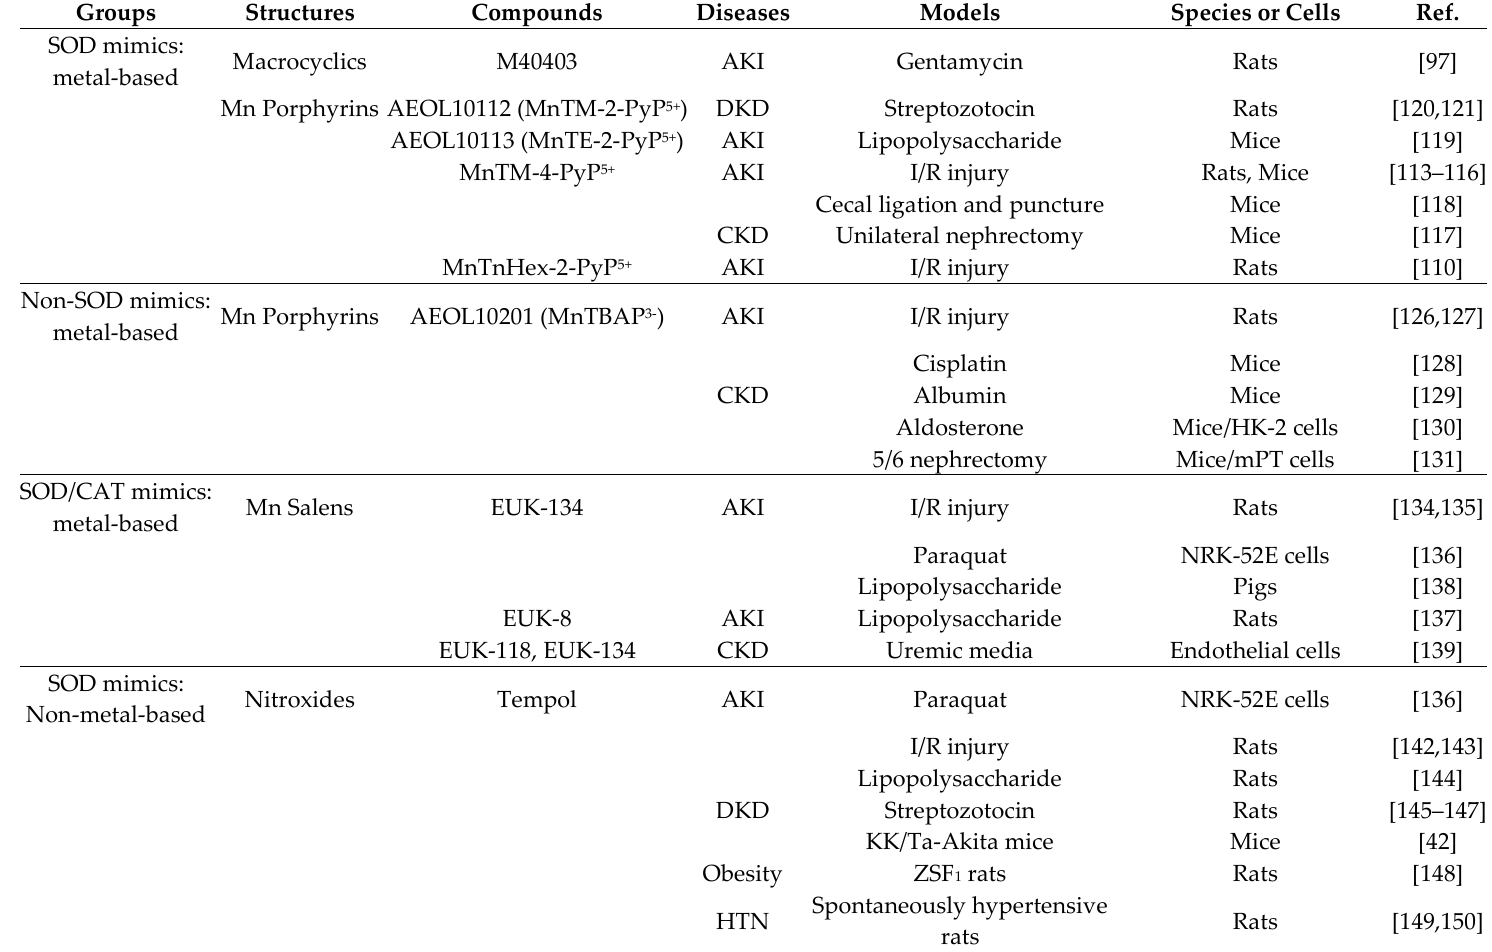
Table 1. Summary of in vitro and in vivo trials of catalytic antioxidants in kidney